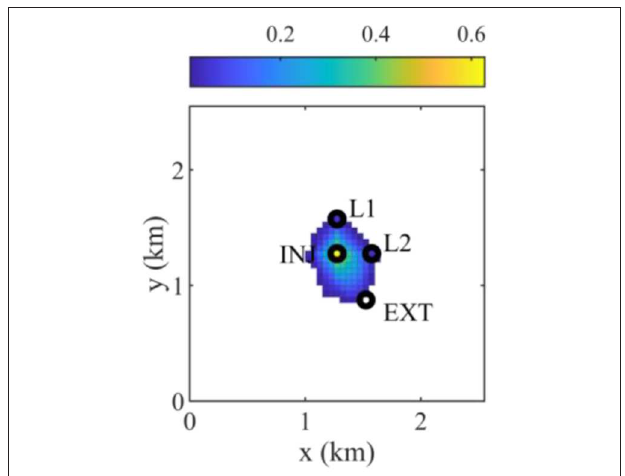
FIGURE 6 | Average CO 2 saturation map of 20 geological models after CO 2 is injected for 5 years when placing a brine extraction well at the optimal location ( I = 31 and J = 18). INJ, EXT, and L1 and L2 represent the CO 2 injector, the brine extraction well, and two leaky abandoned wells,